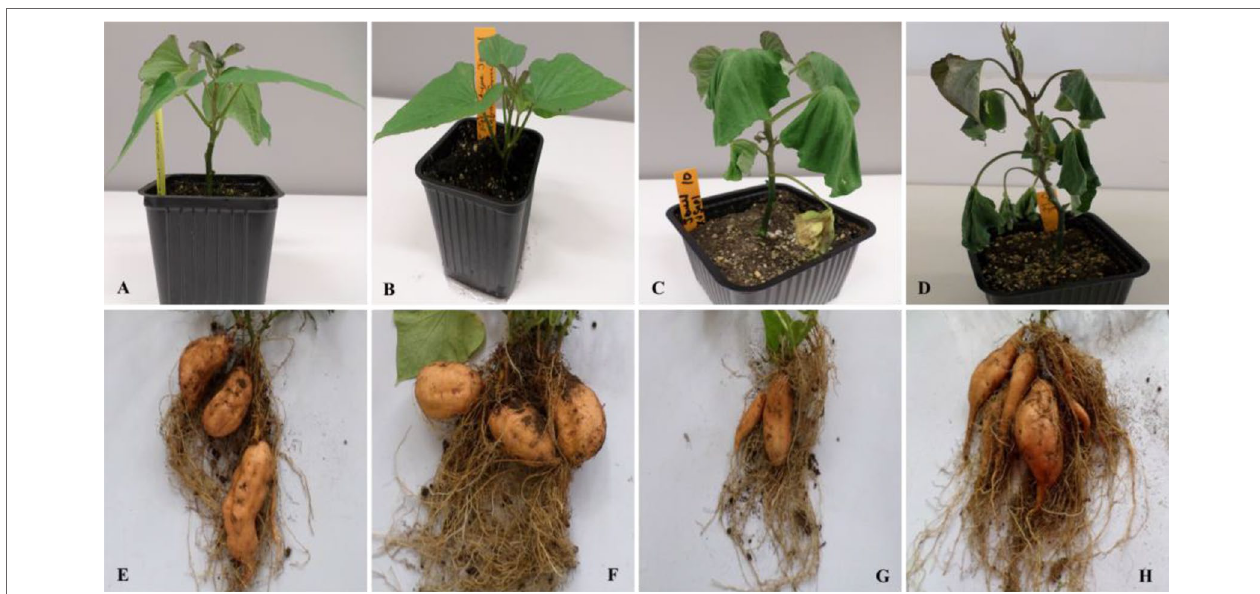
FIGURE 1 | Responses to drought stress in transgenic and wild-type sweet potato plants. (A and B) Morphological appearance of transgenic and wild-type plants, respectively. (C and D) Phenotypes of transgenic and wild-type plants grown in soil after 12 days of drought stress, respectively. (E and F) Yield performance of wild-type and transgenic plants grown under control conditions, respectively. (G and H) Yield performance of wild-type and transgenic plants grown under drought conditions for 90 days,